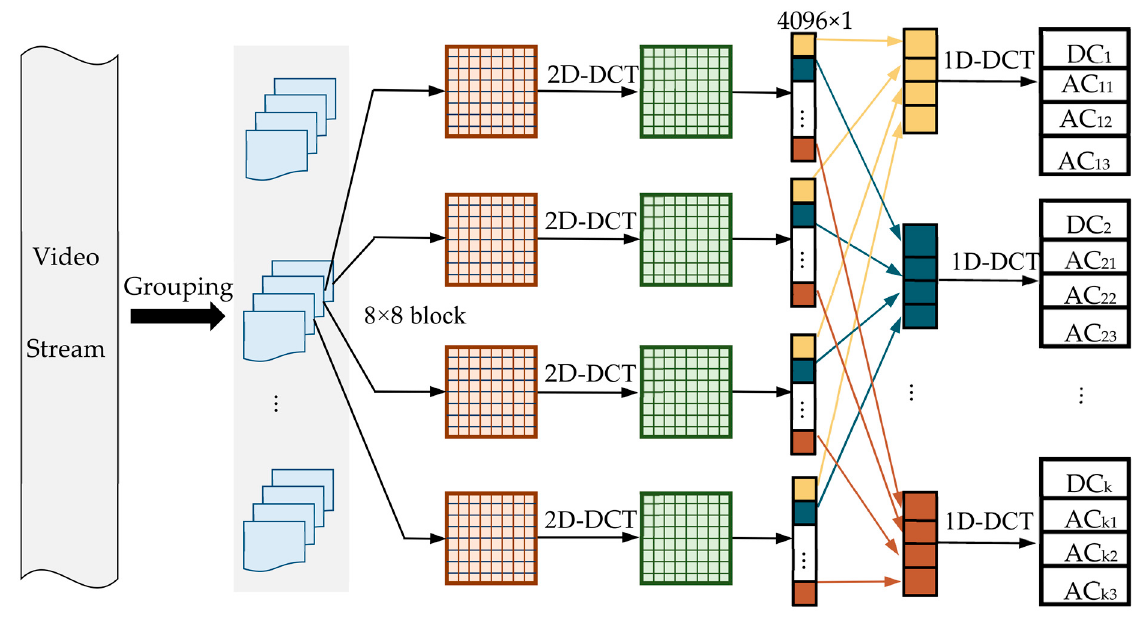
Figure 1. Schematic diagram of the pseudo 3D-DCT principle.